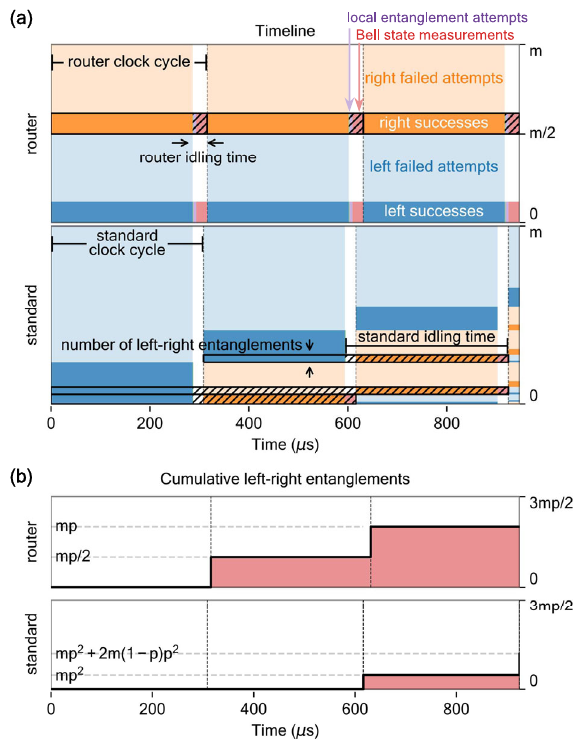
Fig. 3 Timeline of activity for each memory in a standard repeater and a router, in the limit of high multiplexing ( m → ∞ ). Note that for visibility, here p distant is set to 0.2, which is 250 × the value in our simulations. a The horizontal axis represents time — three router clock cycles are shown here — and the vertical axis represents the number of memories involved in each stage of entanglement generation. The different stages of entanglement generation are color-coded. Full left-right entanglements are represented by boxes, the height of which is the number of left-right entanglements and the length of which is the time from the fi rst successful distant entanglement attempt to the formation of left-right entanglement. The idling time of the fi rst distant entanglement is hatched. Both the standard repeater and router are initialized with no entanglement at time = 0 μ s. The router has a signi fi cantly shorter idling time t idle than the standard repeater. (See Supplementary Note 5 for more details.) b The horizontal axis represents time (on the same scale as in a ), but the vertical axis represents the cumulative number of Alice – Bob entanglements generated at any given